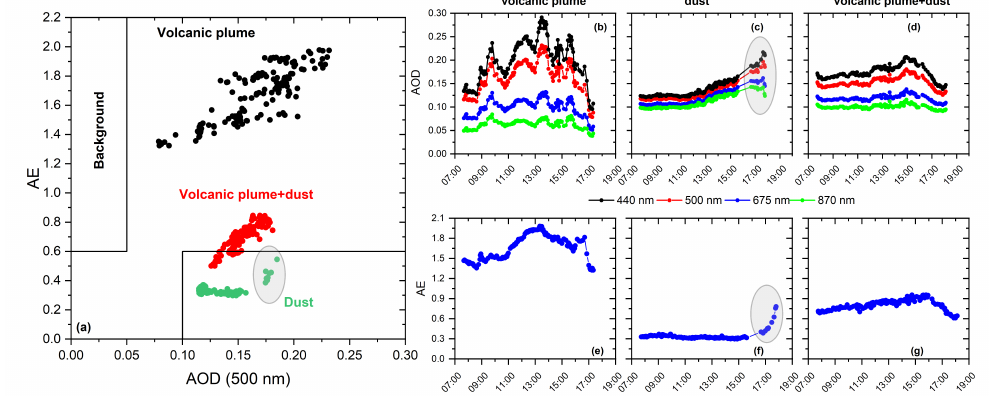
Figure 5. ( a ) Scatterplots of AE versus AOD 500nm for the three case studies: volcanic plume (black dots), dust (green dots), and volcanic plume + dust (red dots) at the IZO. The black lines indicate the threshold limits established for the background and dust conditions at the IZO. Right panels display the evolution of the AOD ( b – d ) and AE ( e – g ) for the three case analyses: volcanic plume, dust, and volcanic plume + dust at the IZO. The AOD is shown at AERONET channels of 440 nm (black), 500 nm (red), 675 nm (blue), and 870 nm (green). Grey circles indicate the arrival of a volcanic plume in the event dominated by mineral